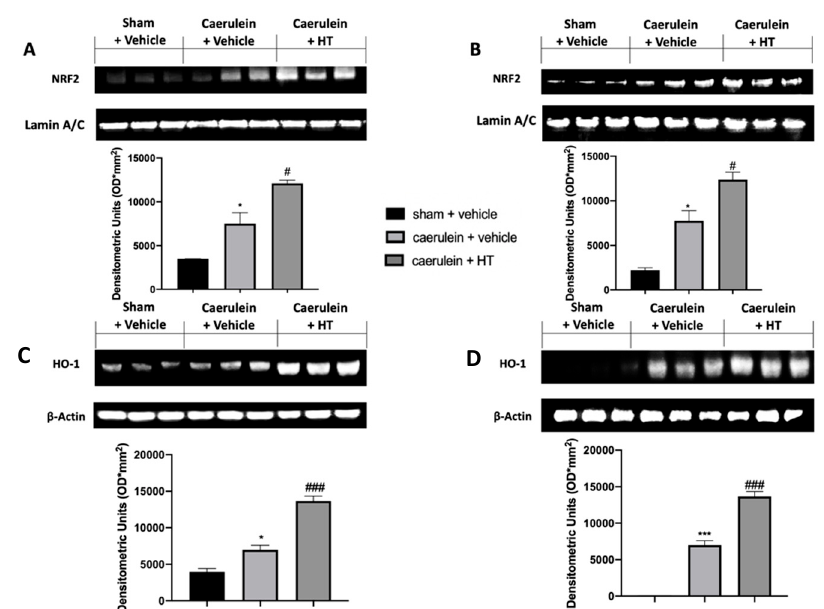
Figure 3. Hydroxytyrosol (HT) effect on nuclear factor erythroid 2-related factor 2 (Nrf2)/ heme oxygenase 1 (HO-1) expression: Western blot analysis of: Nrf2 from pancreatic tissue ( A ), Nrf2 from colonic tissue ( B ), HO-1 from pancreatic tissue ( C ), HO-1 from colonic tissue ( D ). For each analysis, n = 5 animals from each group were employed. A p -value < 0.05 was considered significant. * p < 0.05 vs. sham + vehicle, # p < 0.05 vs. caerulein + vehicle, *** p < 0.001 vs. sham + vehicle, ### p < 0.001 vs. caerulein + vehicle.